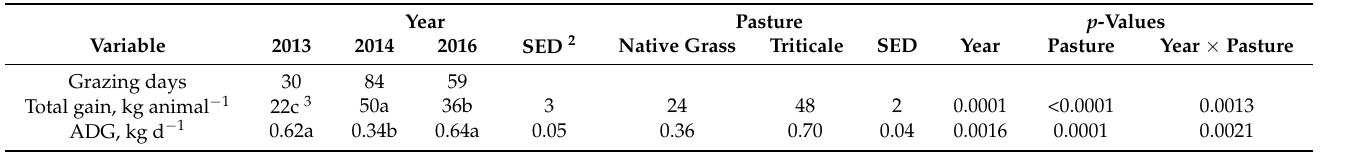
Table 4. Grazing period total and season mean average daily gain (ADG) of growing beef cattle grazing native grass or triticale pastures grazed during the late winters of 2013, 2014, and 2016 1 at Tucumcari, NM USA. Values are the means of two pasture replicates within each year. Year Pasture p -Values Variable